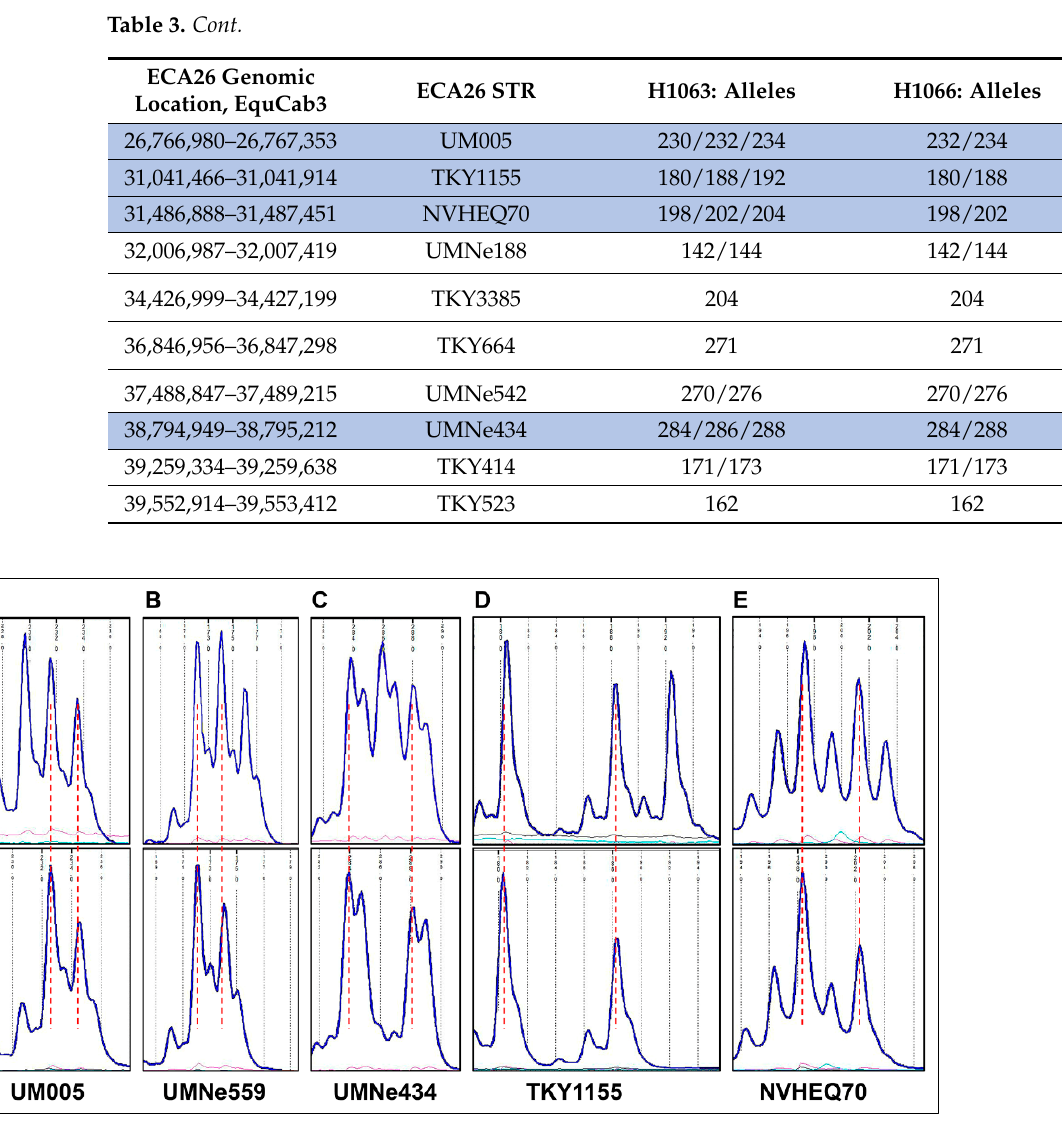
Figure 2. Genotyping results for ECA26 STRs UM005 ( A ), UMNe559 ( B ), UMNe434 ( C ), TKY1155 ( D ), and NVHEQ70 ( E ) showing the presence of three alleles in the foal H1063 (upper row) and two alleles in its dam H1066 (lower row). Note that for each STR, the two alleles present in the dam are shared with the foal. Allele size scales are aligned between the foal and the dam (vertical red dotted lines).